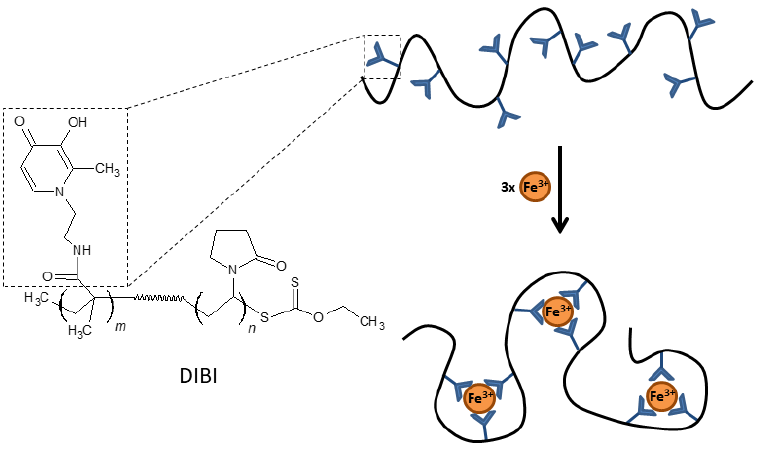
Figure 3. Chemical structure and schematic representation of Fe(III) binding by